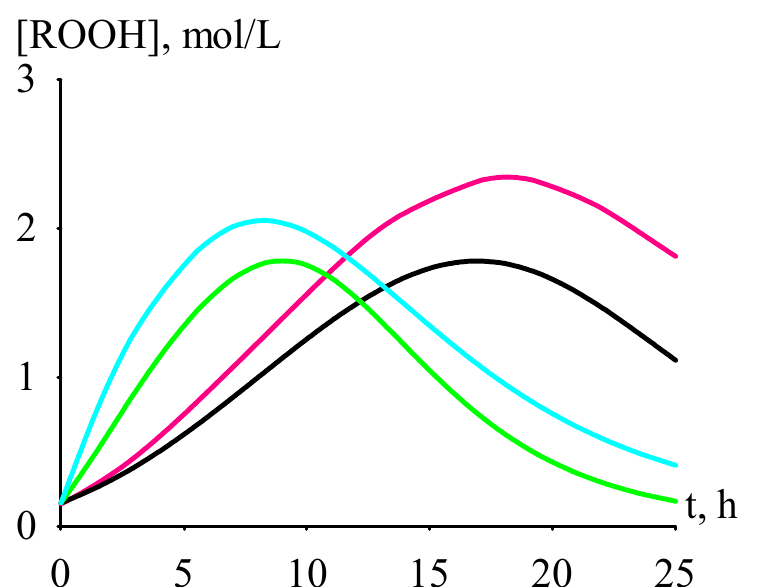
Figure 3. The dependencies of cumene hydroperoxide accumulation versus time. Without catalyst Ca Sr Ba . G = 0.6 L/min, T = 393 K, P = 1 atm, [RH] 0 = 6.19 mol/L, [ROOH] 0 = 0.15 mol/L, [ROH] 0 = 0.08 mol/L, [HCOOH] 0 = 0.018 mol/L, [C 6 H 5 C(O)CH 3 ] 0 = 0.024 mol/L, and [Cat] 0 = 1 mmol/L.